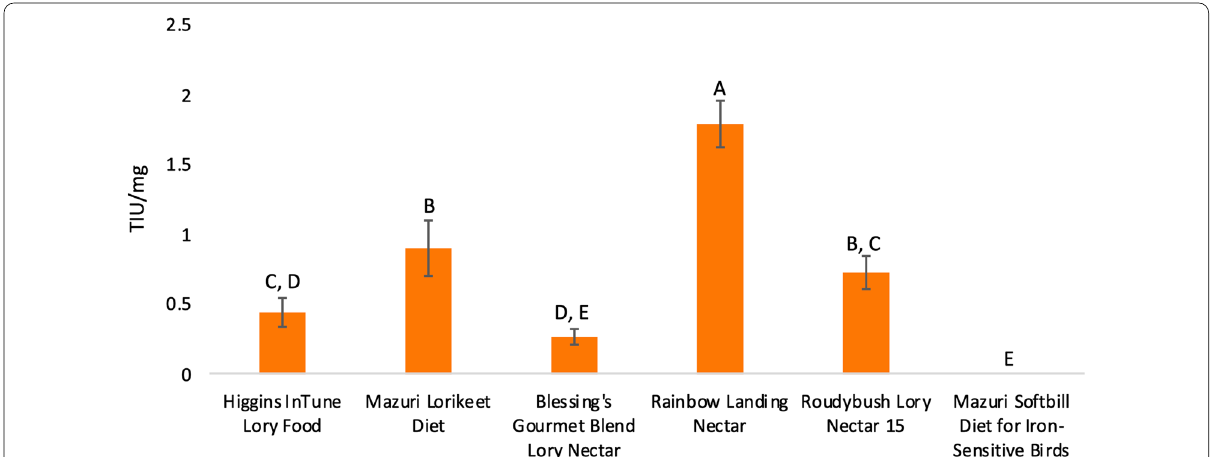
Fig. 6 Trypsin inhibitor measurements in commercial nectars. Trypsin inhibitor units (TIU) per milligram nectar were compared in 6 commercial nectars. Different letters above bars indicate statistically significant differences at p < 0.05 (one‑way ANOVA, Tukey’s test). Bars that share the same letter do not differ significantly. (For example, Mazuri lorikeet diet and Roudybush Lory Nectar 15 share a “B” and do not differ significantly in TIU/